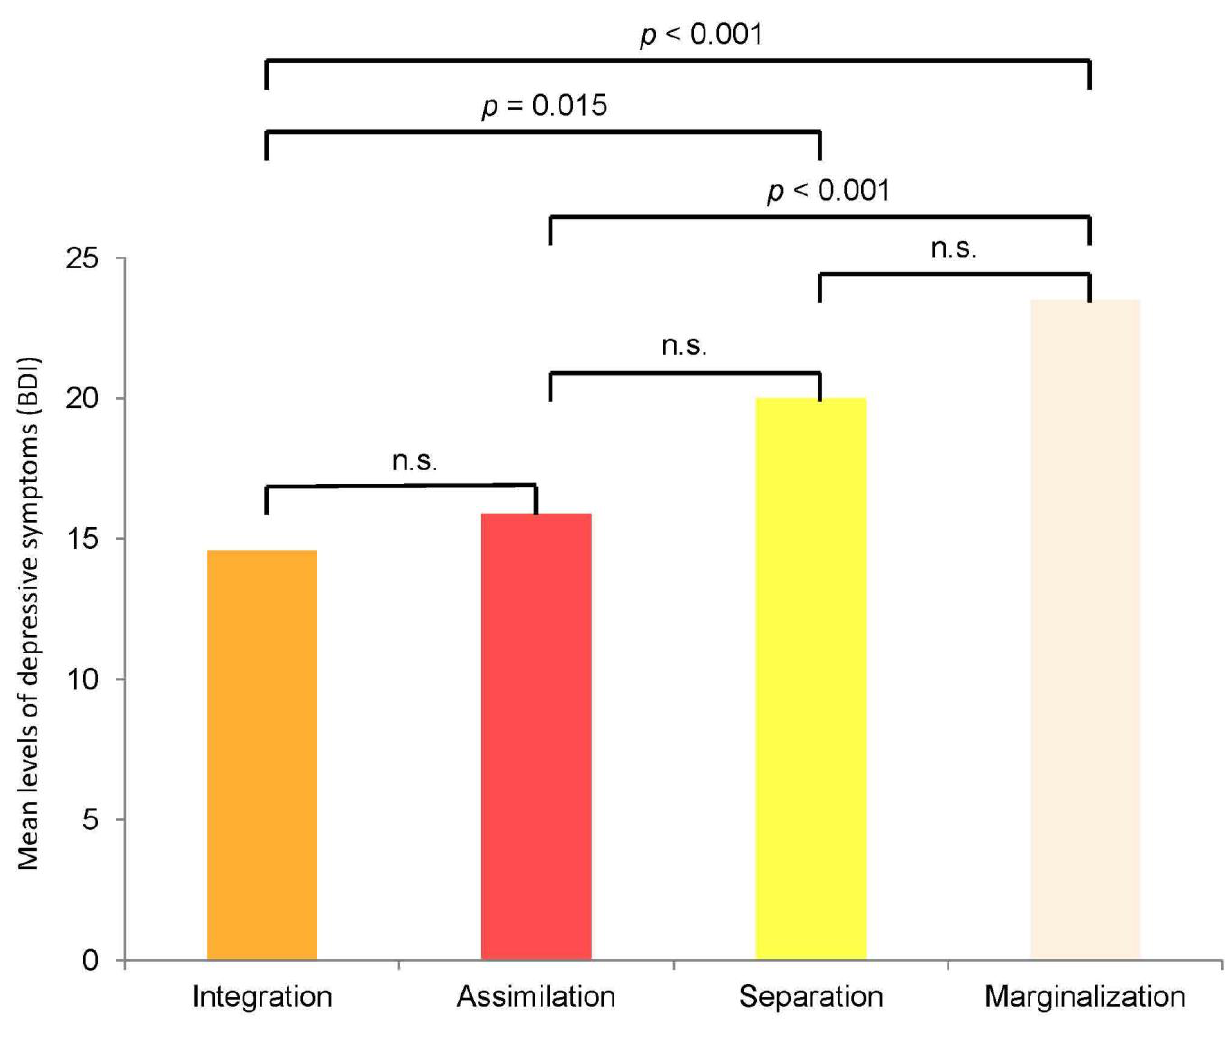
Figure 2. Mean levels of depressive symptoms (BDI) according to acculturation